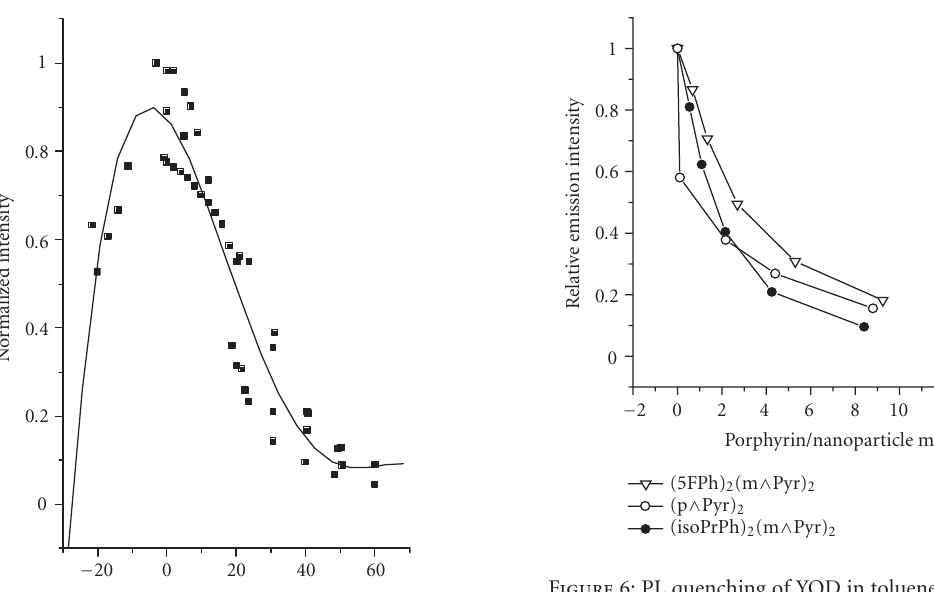
Figure 6: PL quenching of YQD in toluene as a function of ( x ) for 3 di ff erent